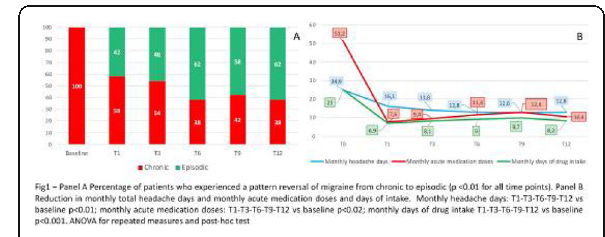
Fig. 1 (abstract P0300). See text for description